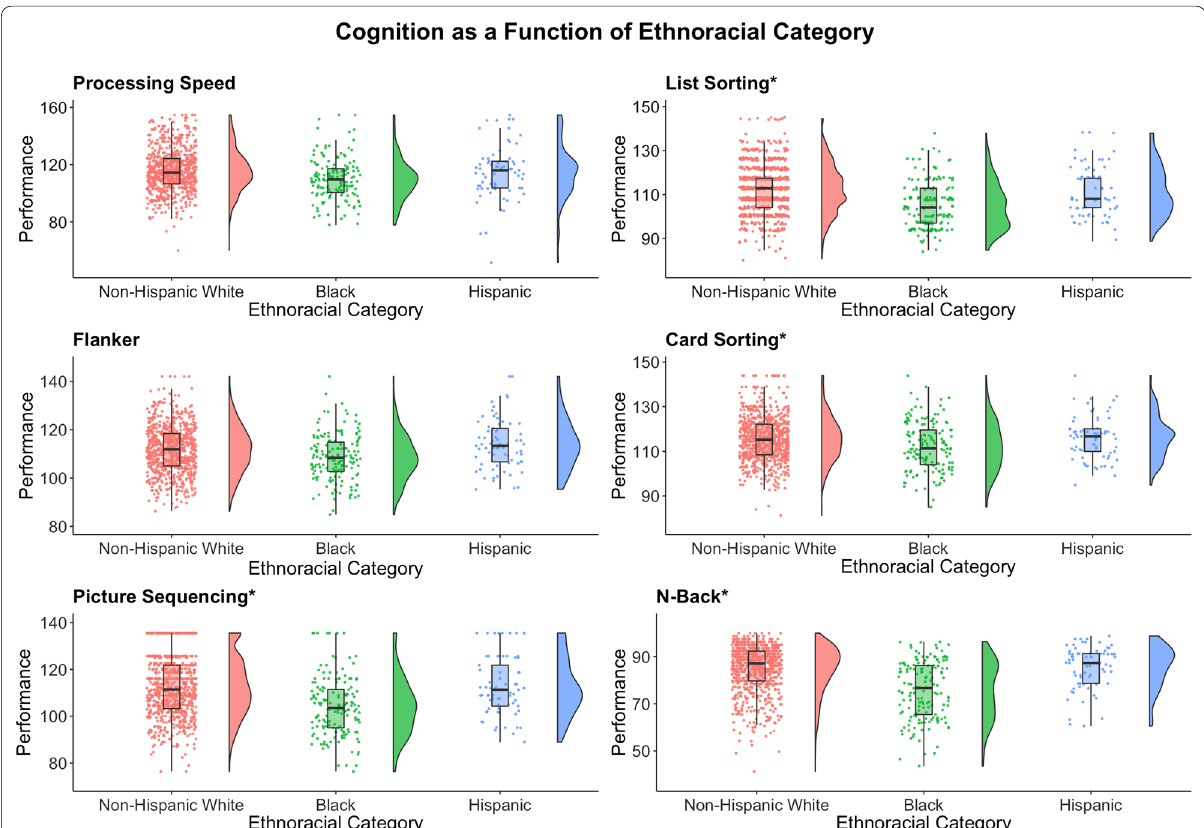
Fig. 2 Raincloud plots are presented illustrating ethnoracial category differences in cognition for Non‑Hispanic White Americans (red), Black American (green), and Hispanic Americans (blue). The asterisks denote which cognitive tasks also were associated with perceived stress and included in the subsequent mediation analyses. Note that the Penn Word Test did not differ by ethnoracial category, likely due to ceiling effects and so is not included. For completeness, no outliers were removed for these comparisons